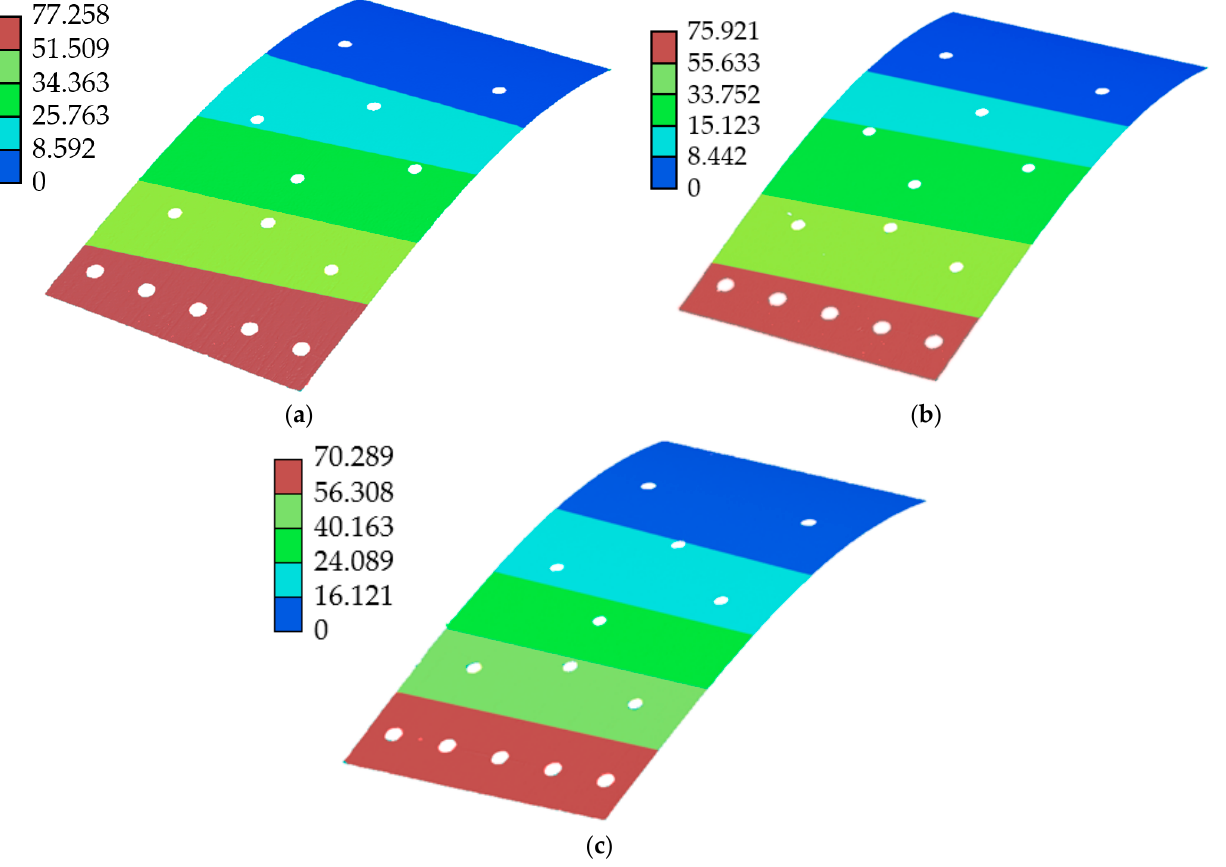
Figure 18. Spatial contours of the deformed FLS under the different loading cases. ( a ) Case 1; ( b ) Case 2; ( c ) Case 3.